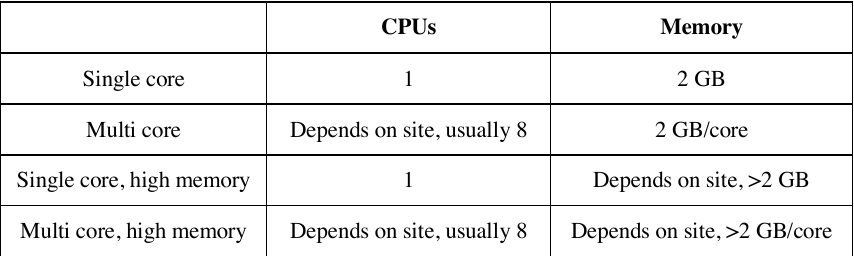
Table 1. Requirements for the various production